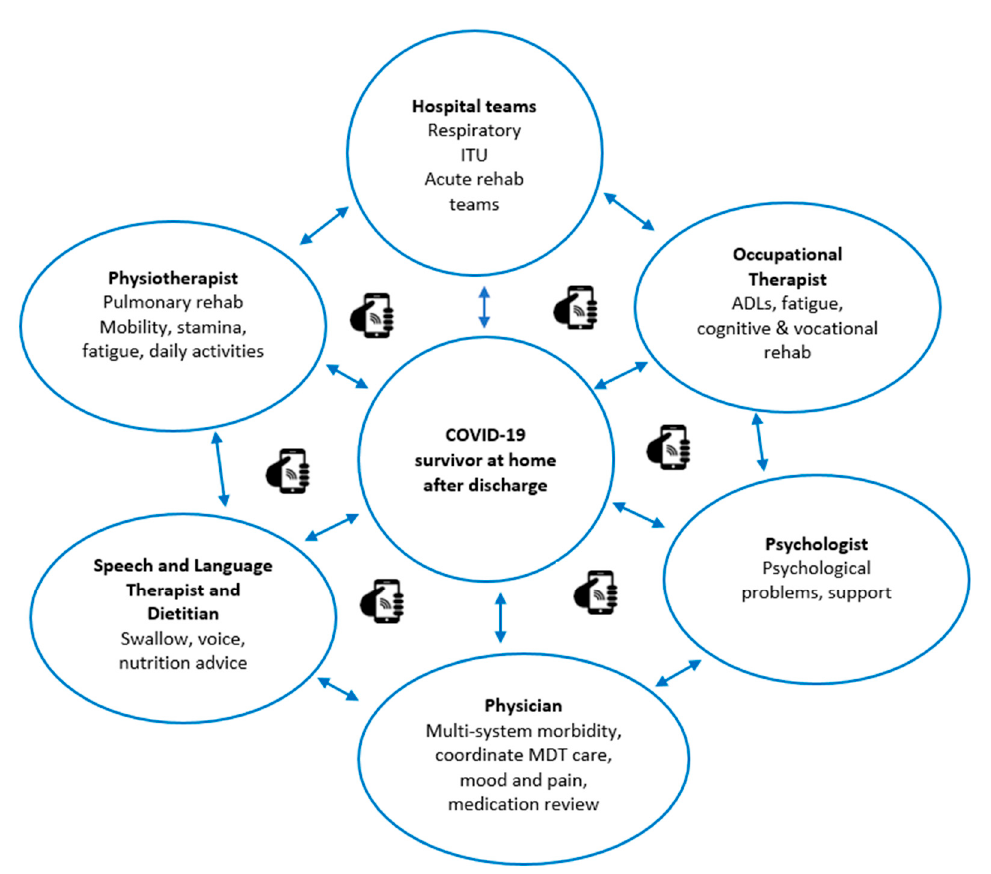
Figure 2. Multidisciplinary tele-rehabilitation model.